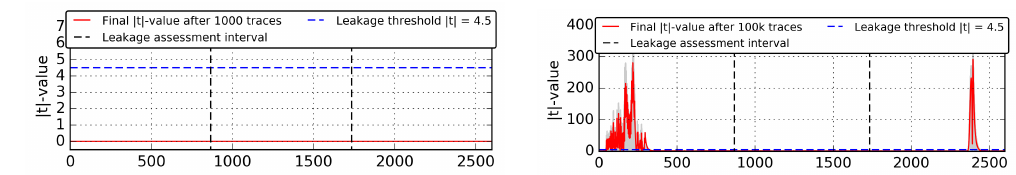
Figure 13: Results of Leakage Assessments on ESP32-devkitC for mbedTLS AES.